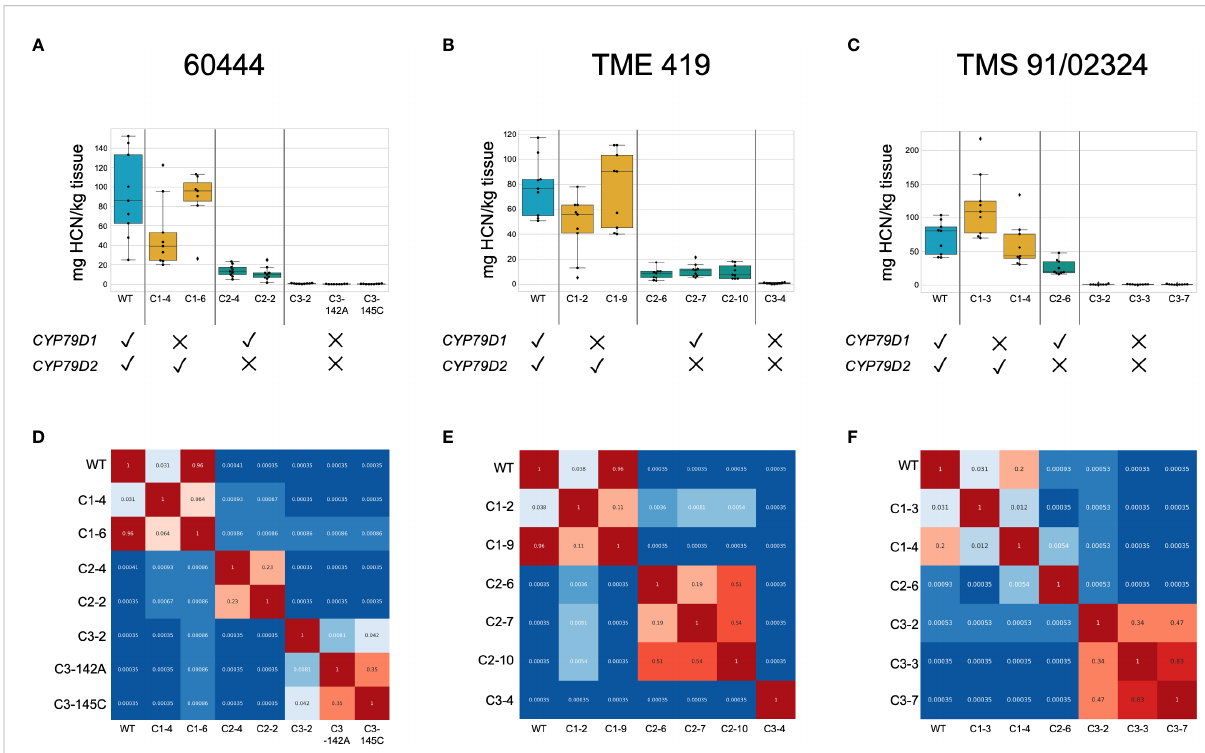
FIGURE 2 Dual knockout of CYP79D1 and CYP79D2 eliminates cyanide production in accessions 60444, TME 419, and TMS 91/02324. Assays were conducted 6.5, 8, and 7.5 months, respectively, after plants were transferred to soil. (A – C) Box and whisker plots of cyanide values in storage roots in mg HCN per kg tissue, as detected by picrate assay. Black dots are biological replicates. The median, and lower (25th percentile) and upper (75th percentile) quartiles are indicated. Whiskers de fi ne the minimum and maximum regions of the data; data points outside of these are outliers. (D – F) Wilcoxon Rank Sum p-values calculated from pairwise comparisons between lines of root cyanide content. Values less than 0.05, indicating the distributions of the values are statistically different between the two lines, are colored in shades of blue. Values greater than 0.05 are colored in shades of red. WT, wildtype. Edited lines are identi fi ed by the CRISPR construct with which they were modi fi ed (C1, C2, C3), followed by an index number (e.g.,